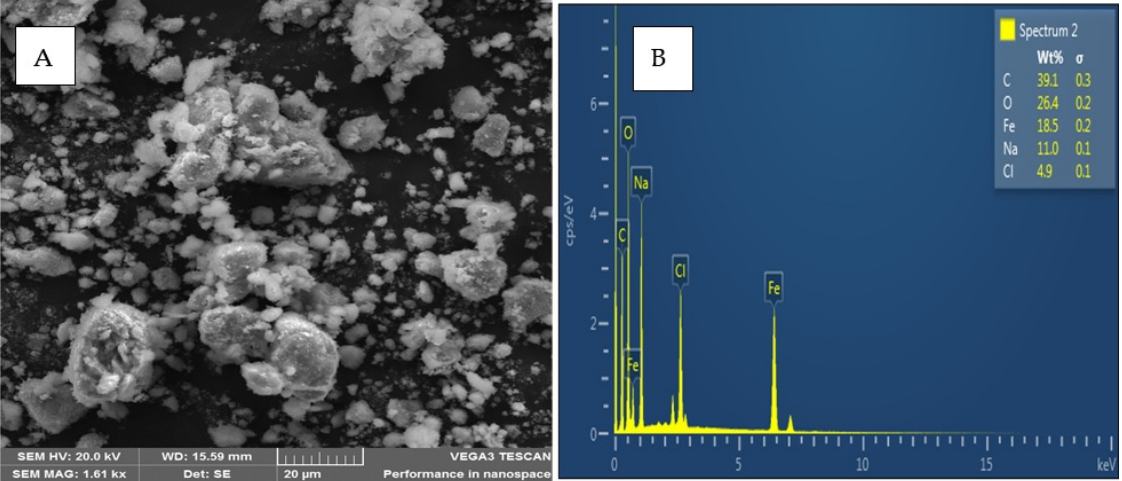
Figure 1. SEM image ( A ) and EDS microgram ( B ) for β -cyclodextrin-decorated magnetic activated carbon.